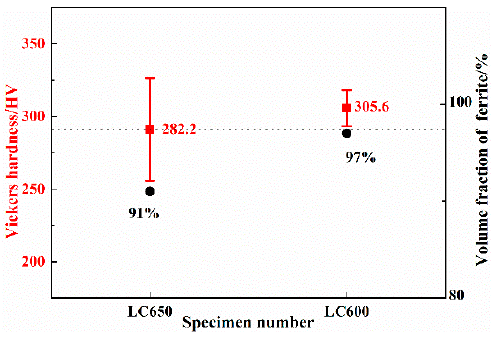
Figure 2. Optical micrographs of as-rolled steel with a start laminar cooling temperature of 650 °C ( a ) and 600 °C ( b ).